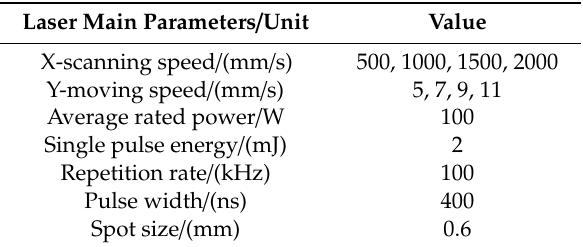
Table 2. Main parameters of laser cleaning process.